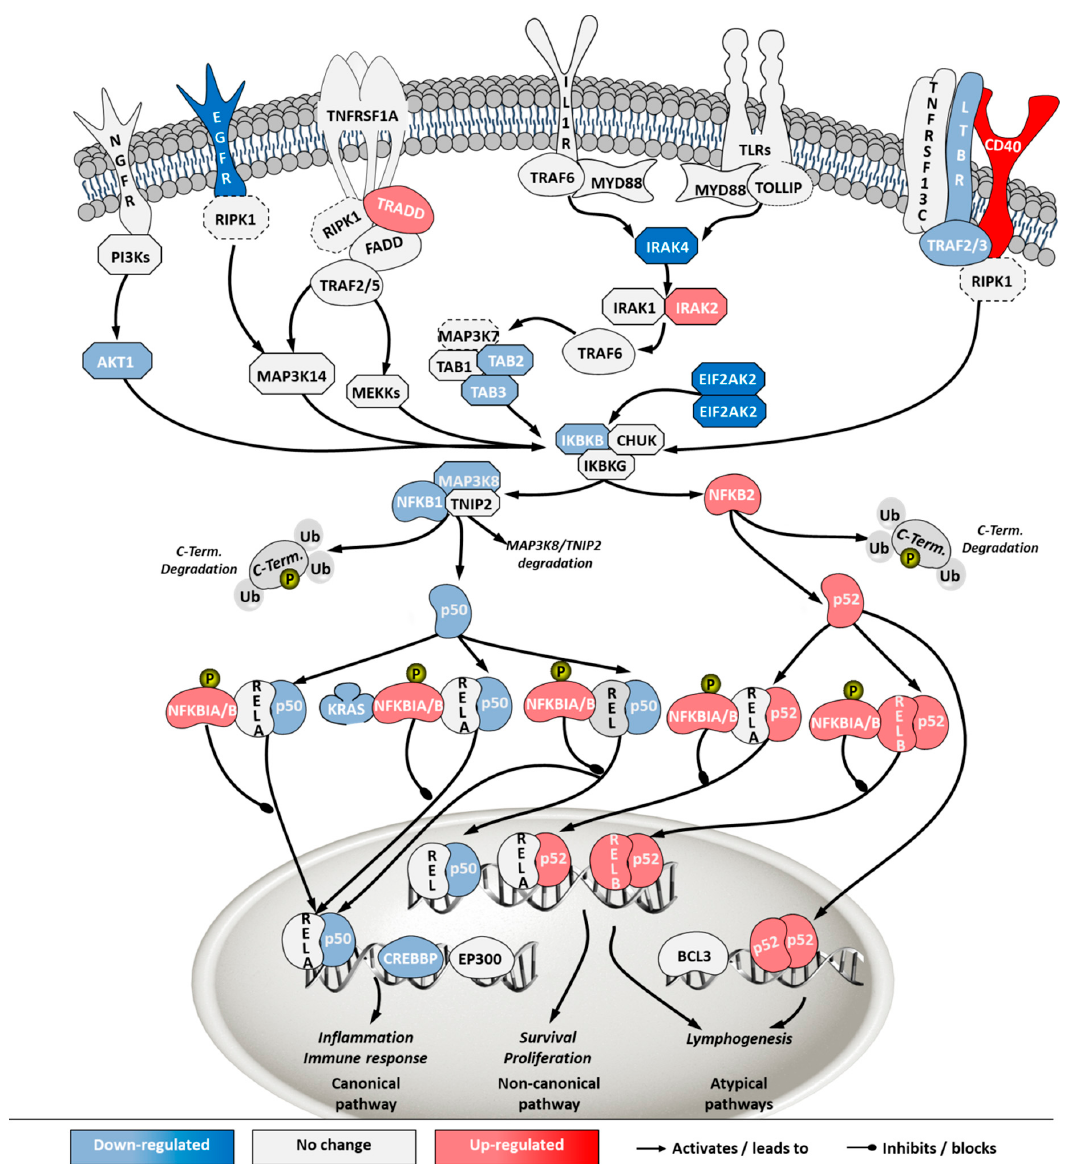
Figure 10. Differential gene expression in nuclear factor kappa-light-chain-enhancer of activated B cells (NF- κ B)pathway in ‘ECACC vs. ATCC’ cells. For further details refer to the caption of Figure 7.